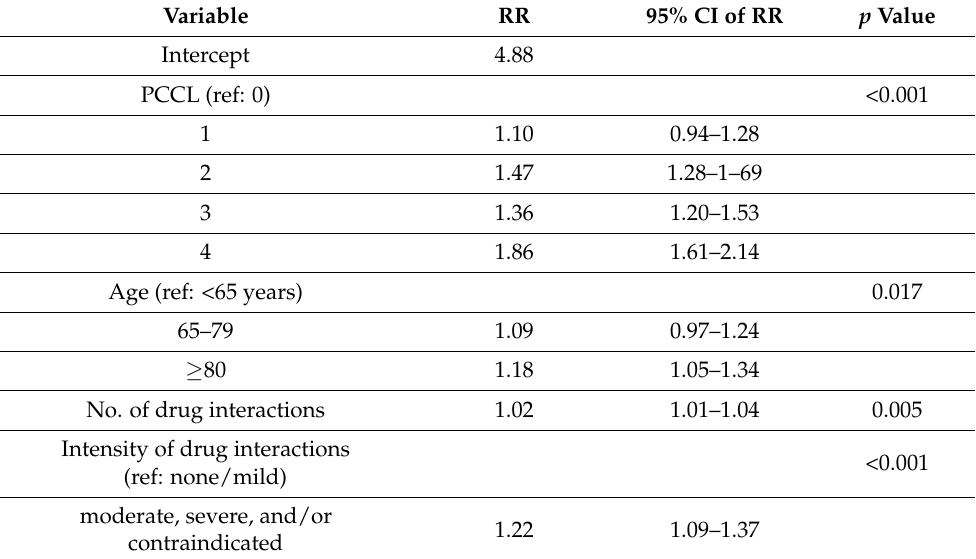
Table 2. Association between hospital LOS and various factors by regression analysis.